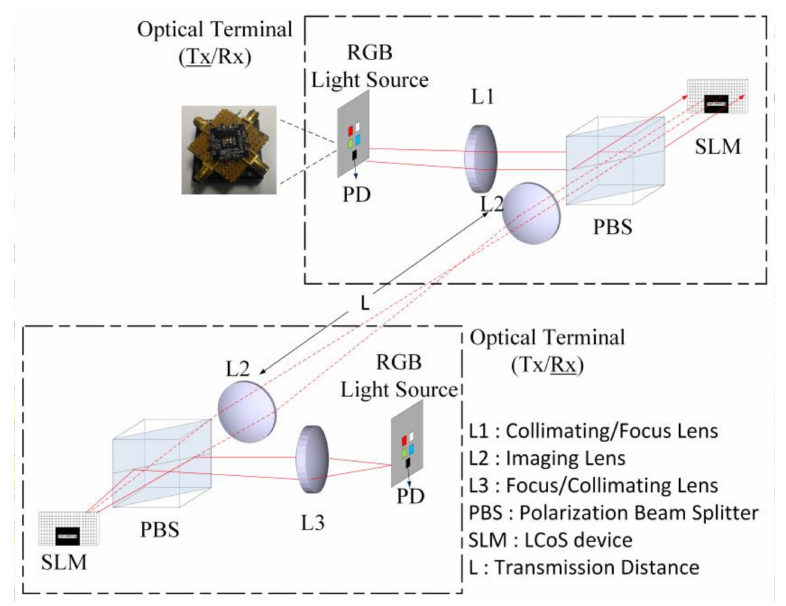
Figure 1. Architecture of short-range bidirectional visible light communication (VLC) based on optical terminals